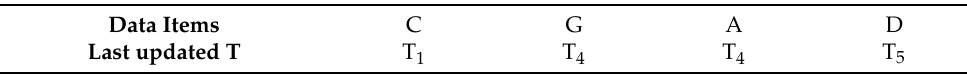
Table 3. Matrix tracking the last updated transactions after T 5 is committed. Data Items